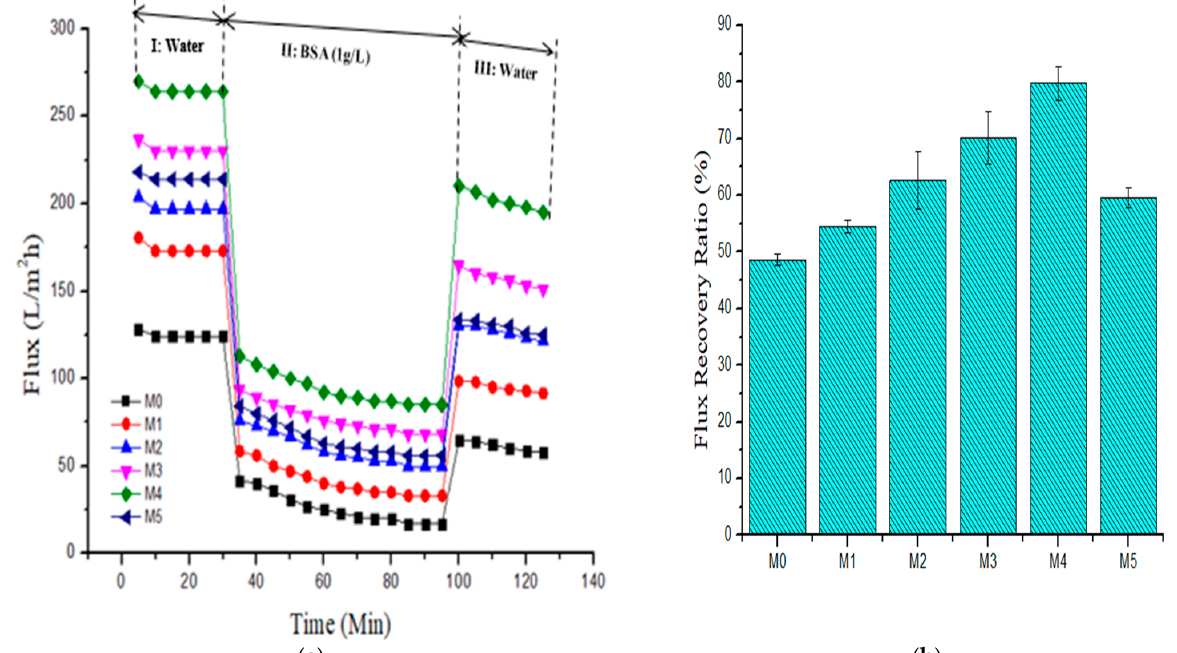
Figure 8. ( a ) Pure water flux and BSA (1 g · L − 1 ) fouling pure water washing cycle and ( b ) resultant flux recovery ratio for fabricated membranes (M 0 ) 0.0 wt %, (M 1 ) 0.05 wt %, (M 2 ) 0.1 wt %, (M 3 ) 0.3 wt %, (M 4 ) 0.5 wt %, and (M 5 ) 1.0 wt %.